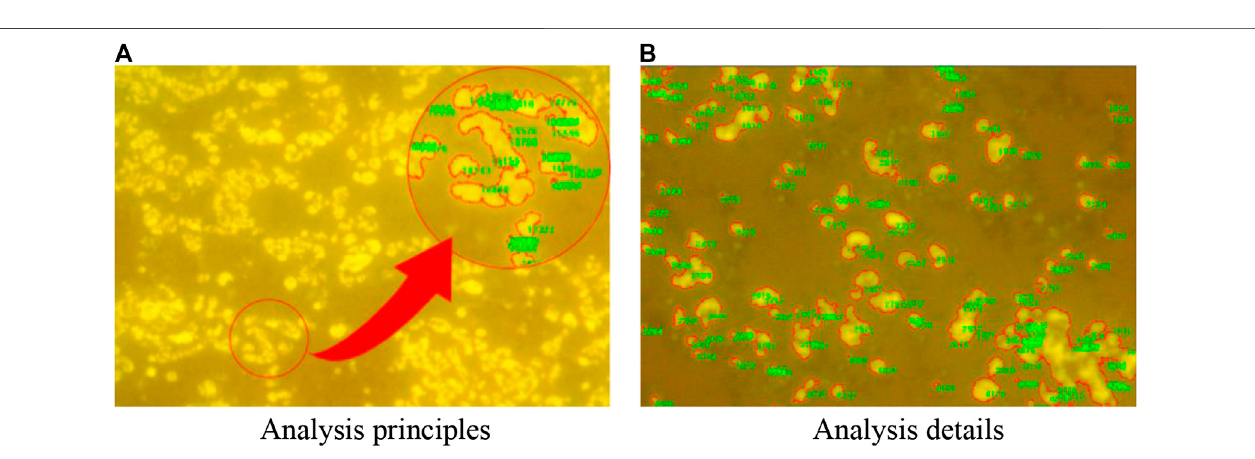
FIGURE 11 | Fluorescence image using IPP software. (A) Analysis principles. (B) Analysis details.